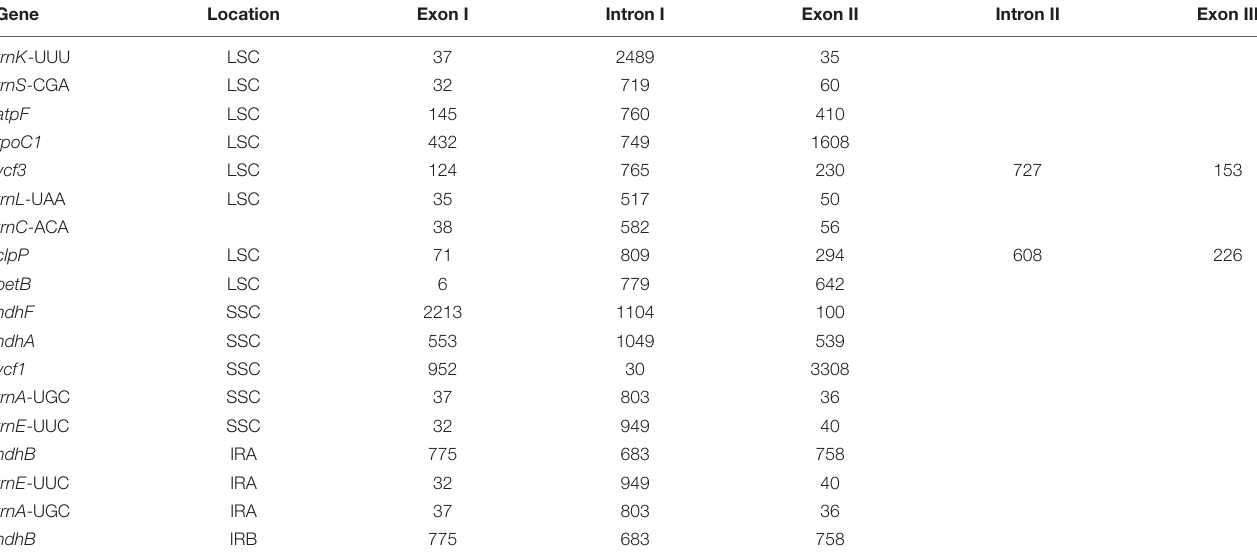
TABLE 3 | Summary of the intron and exon in genes of 16 chloroplast (cp) genomes. Gene Location Exon